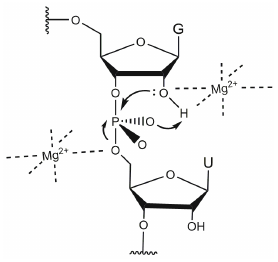
Figure 8. Proposed mechanistic model for the metal ion-mediated RNA cleavage catalysed by a 10-23 DNAzyme Two metal ions (here Mg 2 + ) are involved in a triester-like mechanism, that has originally been proposed for the RNA-cleavage reaction catalysed by a hammerhead ribozyme [105]. One metal ion acts as a Lewis acid and coordinates to the 2’-OH group. Thereby, the OH bond is polarized and migration of the proton to the R P oxygen is facilitated. The second metal ion coordinates to the 5’-oxygen leaving group and neutralizes the negative charge during the cleaveage of the P-O bond. Based on Reference